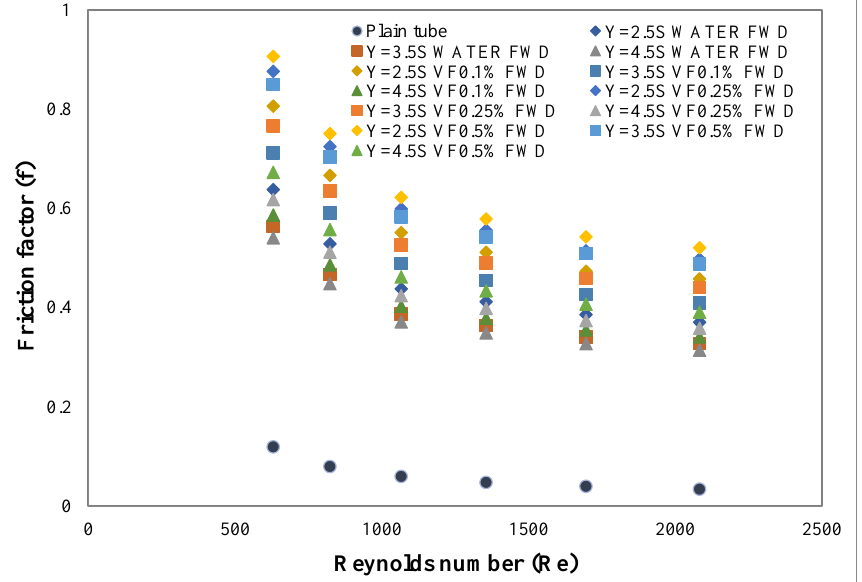
Figure 12. Friction factor versus Reynolds number for a staggered conical strip insert with the forward arrangement using deionized water and ZrO 2 / deionized water nanofluids under laminar flow conditions.